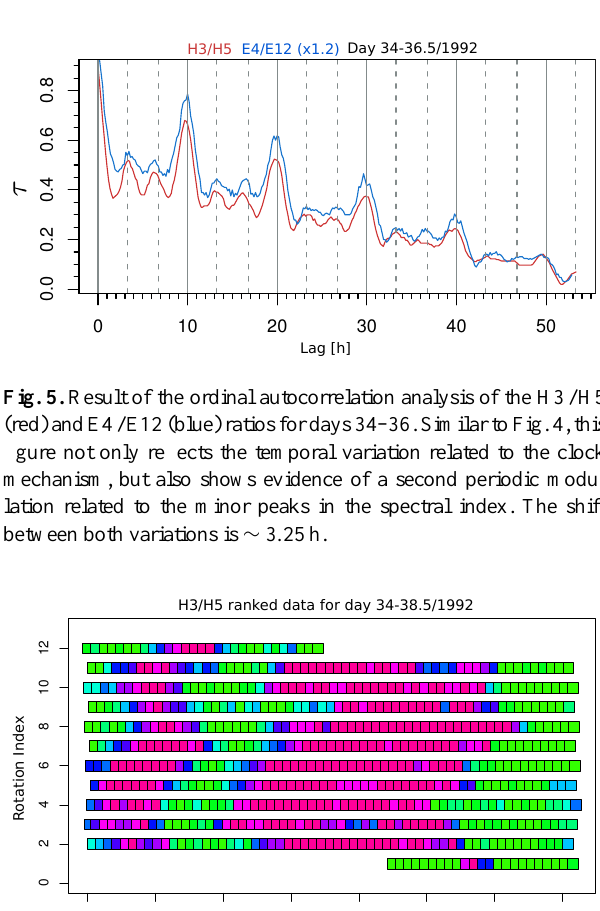
responds to the time interval between the double peaks of the principal flux enhancements, giving further evidence that this is a systematic effect. The analysis of H3, however, shows no